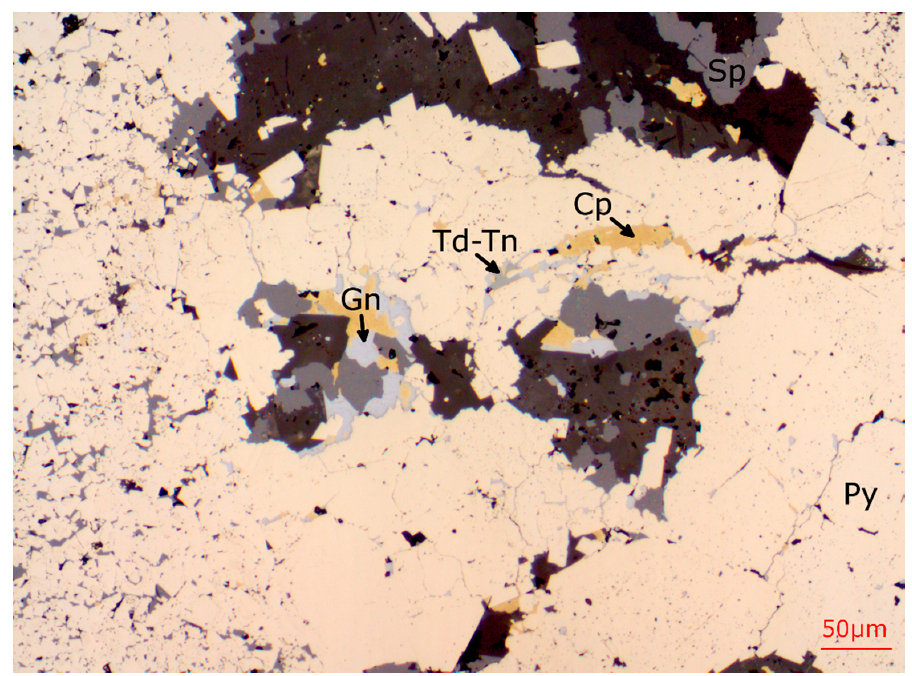
Figure 5. Reflected light photomicrograph from the L4-7-105.7 polished thin section. Pyrite textures transition with fine aggregate textures (with interstitial Sp) on the left and coarser aggregate textures progressing to the right in this image. Some Py, Cp, and Sp grains, as seen at the top centre, are isolated in the non-sulphide gangue minerals and are subhedral.